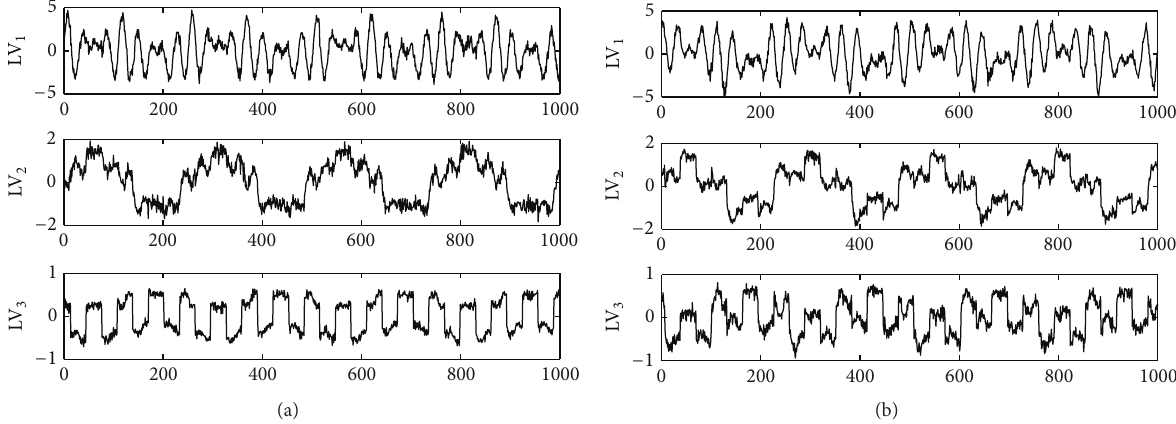
Figure 3: (a) The LVs estimated in X using PLS. (b) The LVs estimated in Y using PLS.